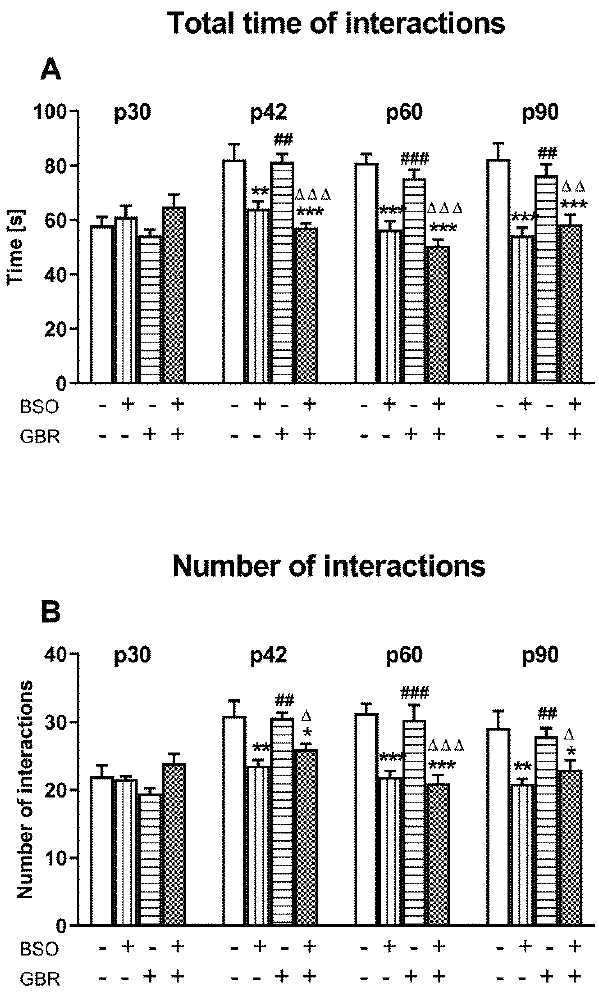
Figure 1. The effect of chronic administration of BSO and GBR 12909, alone or in combination, during postnatal days p5–p16 on the social behavior assessed as the total time spent in social interactions ( A ) and the number of interactions ( B ) in adolescent and adult Sprague–Dawley rats. Data are presented as the mean ± SEM, n = 16 (8 pairs) for each group. Statistical analysis was performed using a two-way ANOVA; symbols indicate significance of differences according to the Newman–Keuls post hoc test, *** p < 0.001, ** p < 0.01, * p < 0.05 vs. control; ### p < 0.001, ## p < 0.01 vs. BSO- and ∆∆∆ p < 0.001, ∆∆ p < 0.01, ∆ p < 0.05 vs. GBR 12909-treated groups.